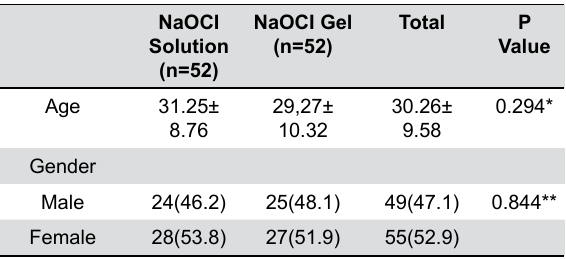
Figure 2- The Consolidated Standards of Reporting Trials 2010 flow diagram Table 1- Comparison of Age, Gender and Pre-Operative Pain Values by